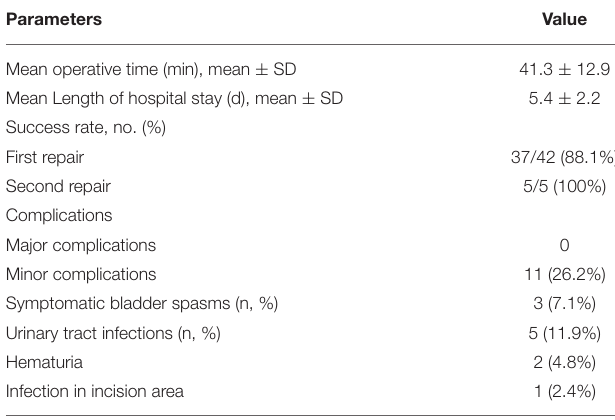
TABLE 1 | Demographic and clinical characteristics of 42 patients. TABLE 2 | Operative and post-operative